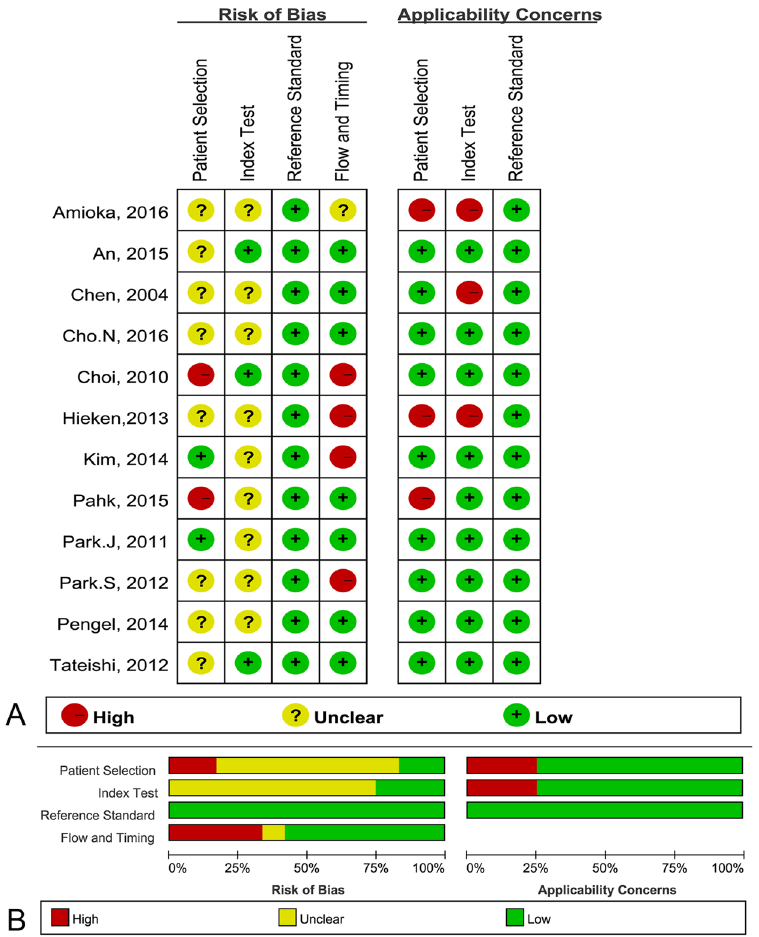
Figure 2. Methodological quality of the 12 included studies. ( A ) Risk of bias and applicability concerns summary; ( B ) risk of bias and applicability concerns